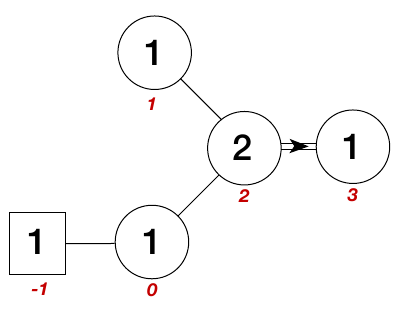
Figure 4 . The framed a(cid:14)ne B 3 quiver, also denoted by [ b B 3 ], with